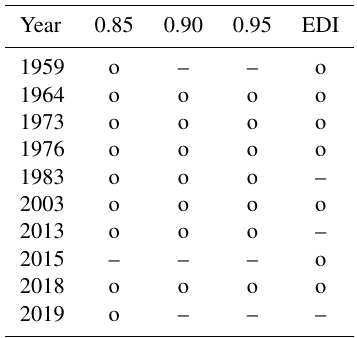
Table 7. As in Table 3 but for drought in the GE region during